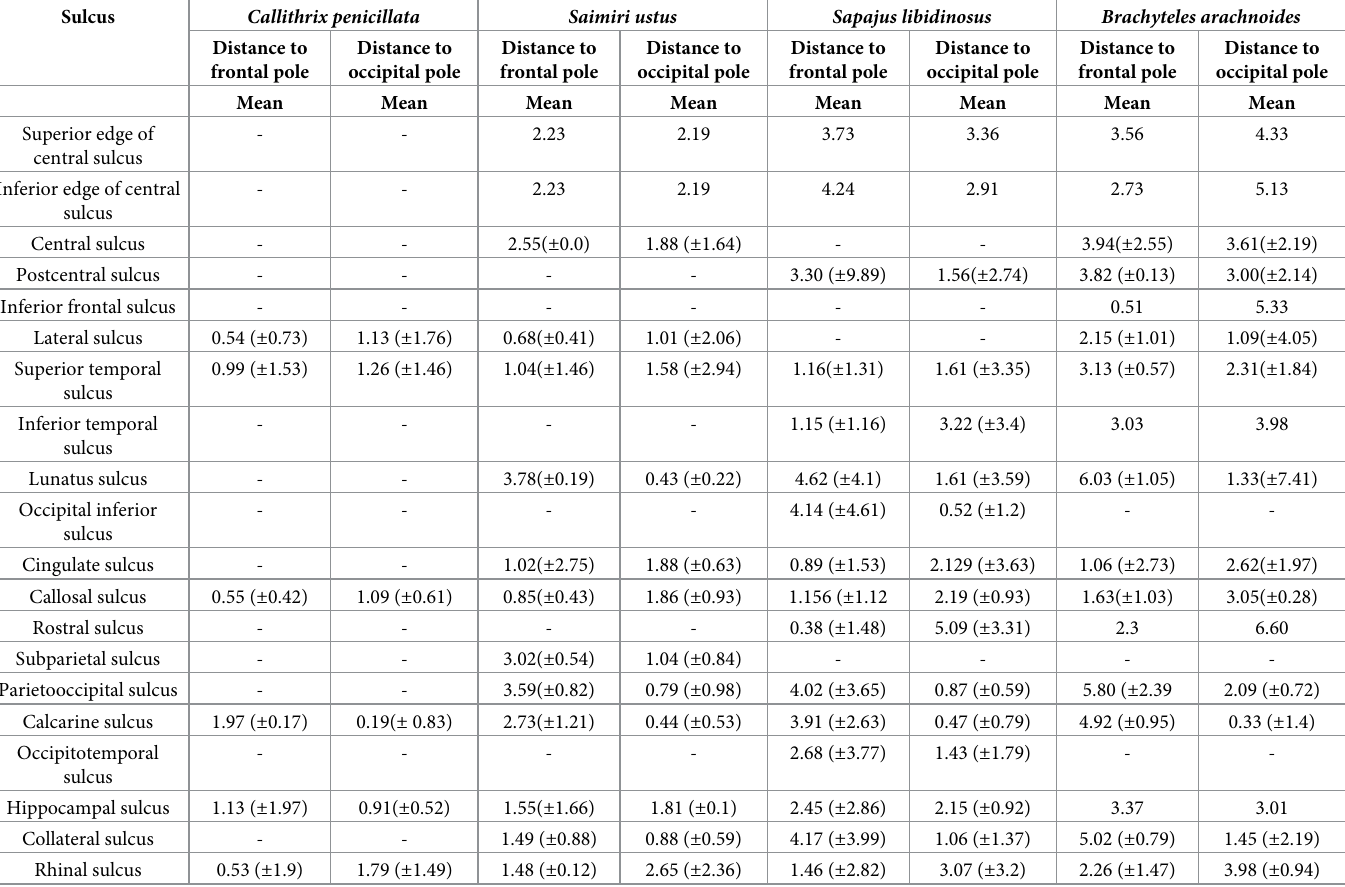
Table 3. Absolute measurements (cm), of the distance between the main sulci and the occipital and frontal poles. Sulcus